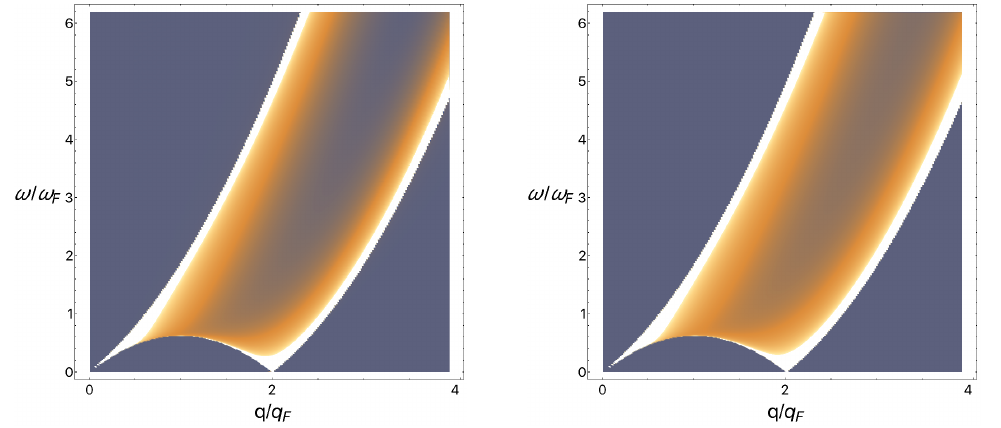
Figure 3: S ( q , ω ) (left panel) and S ( 1 ) ( q , ω ) (right panel) as functions of q and ω at zero temperature and D = 0.404, c = 3 in (106). The color scale is the same for both plots.